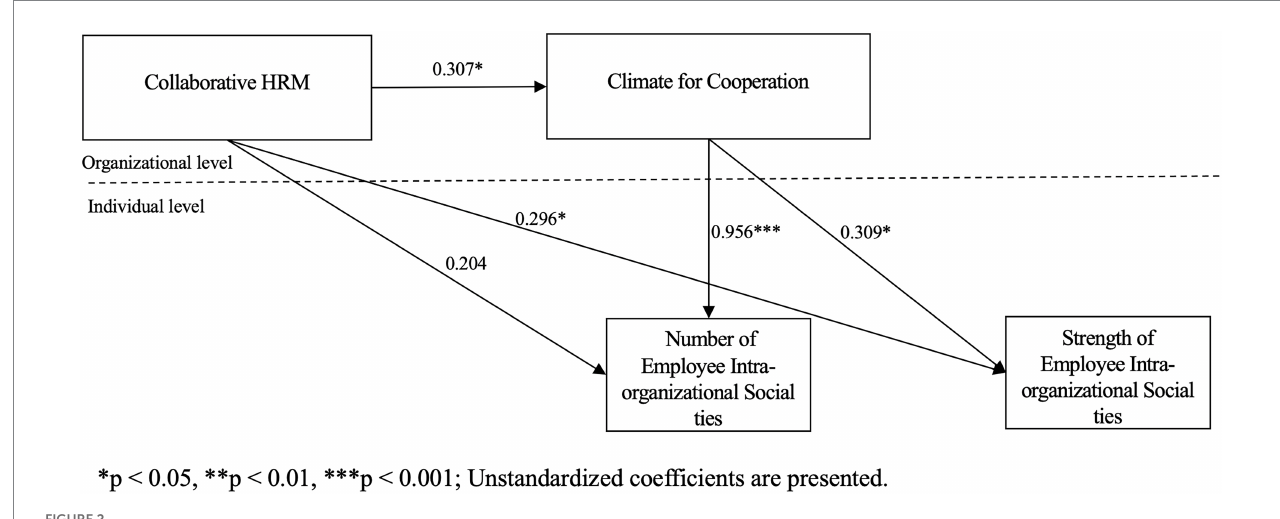
FIGURE 2 Results of multilevel mediation analysis.